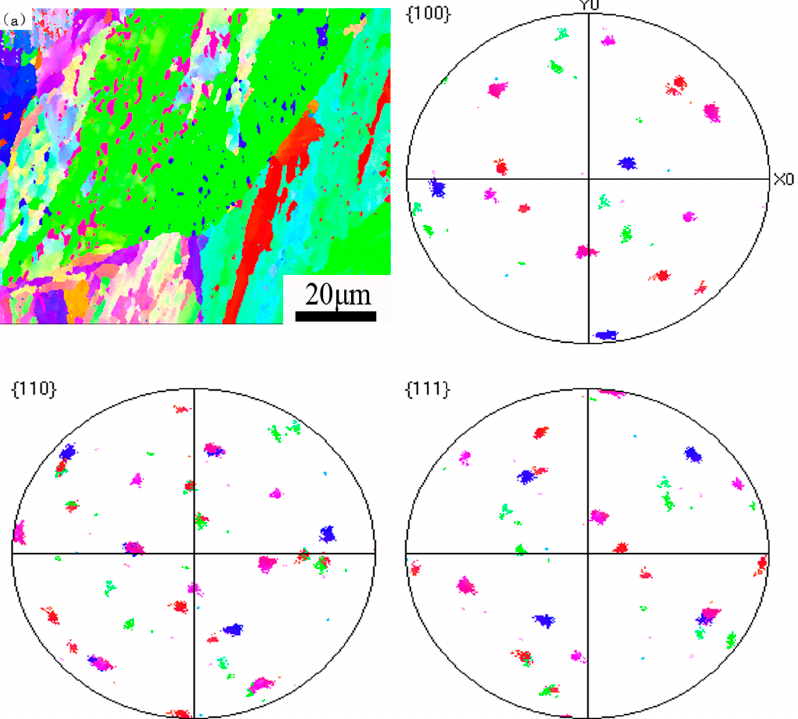
Figure 6. Crystallographic orientation maps and inverse pole figure of the martensite matrix and reversed austenite and (100), (110), (111) pole figure of the reverted austenite showing orientations corresponding to the EBSD orientation